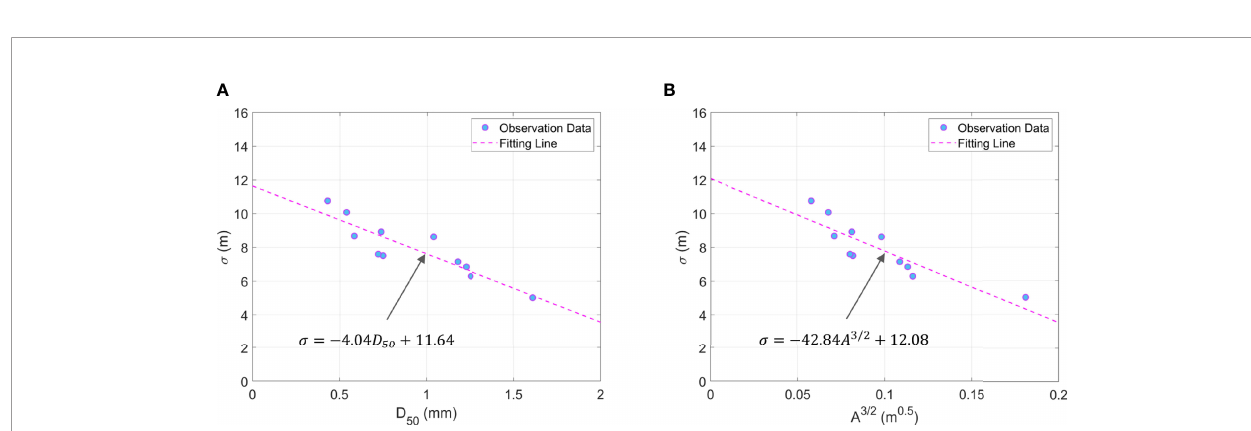
FIGURE 4 | Probability distributions of shoreline data surveyed on 11 representative beaches of the east coast of Korea: (A) GW05 (B) GW13 (C) GW17 (D) GW18 (E) GW22 (F) GW23 (G) GW25 (H) GW26 (I) GW27 (J) GW31 (K) GW36.